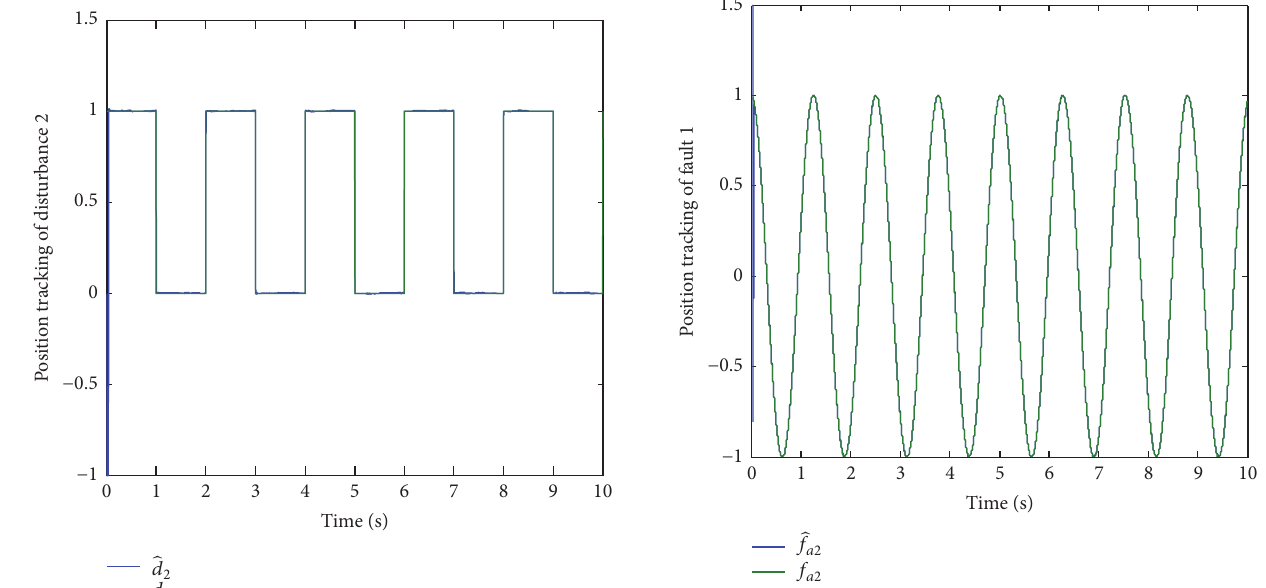
Figure 12: Unknown input disturbance 𝑑 2 and its estimation value.